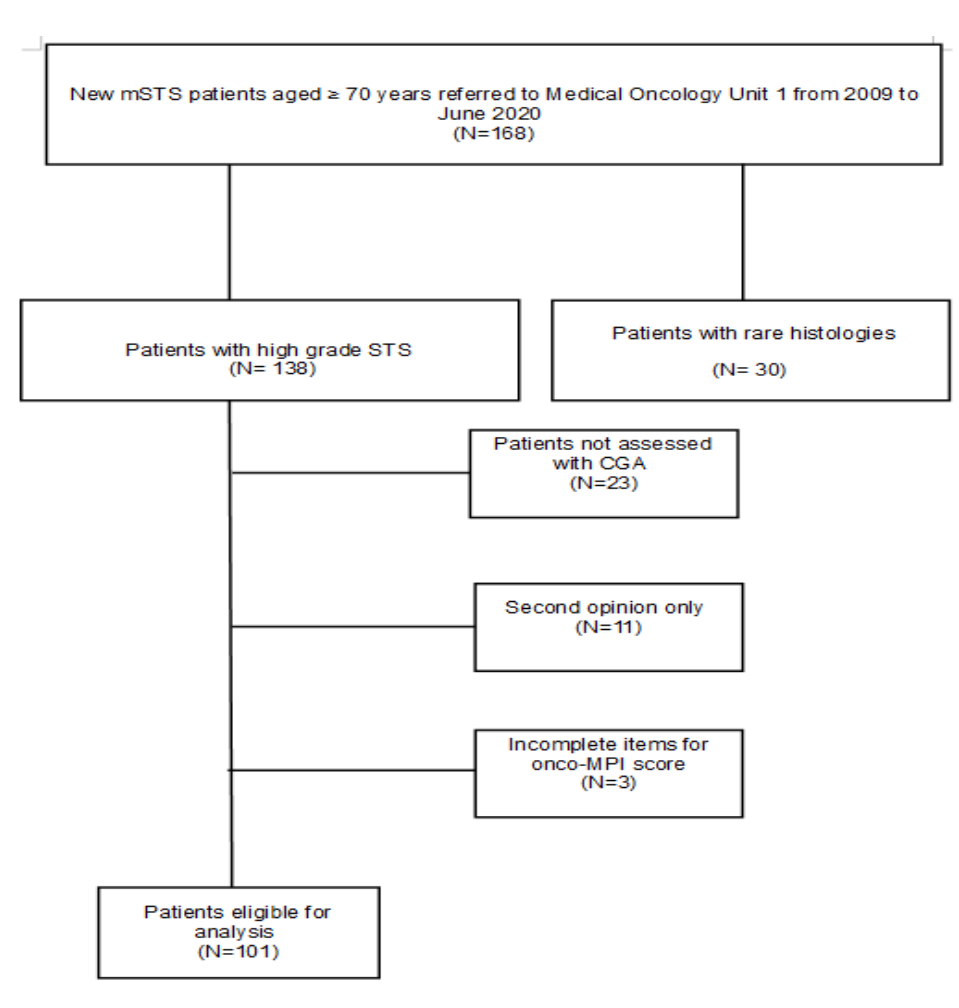
Figure 1. CONSORT flow diagram.